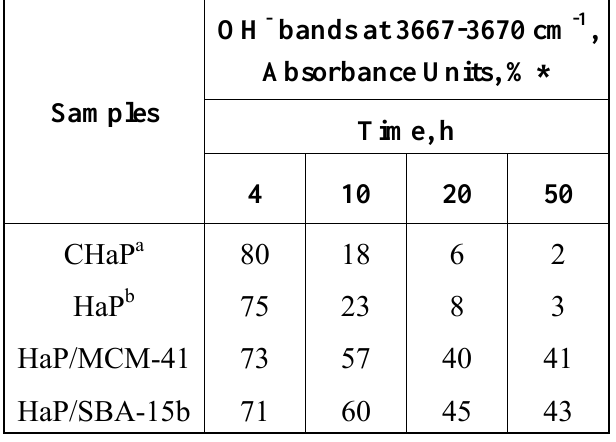
Table 2. OH - bands of HaP, in % Absorbance Units, at different times after fluoride